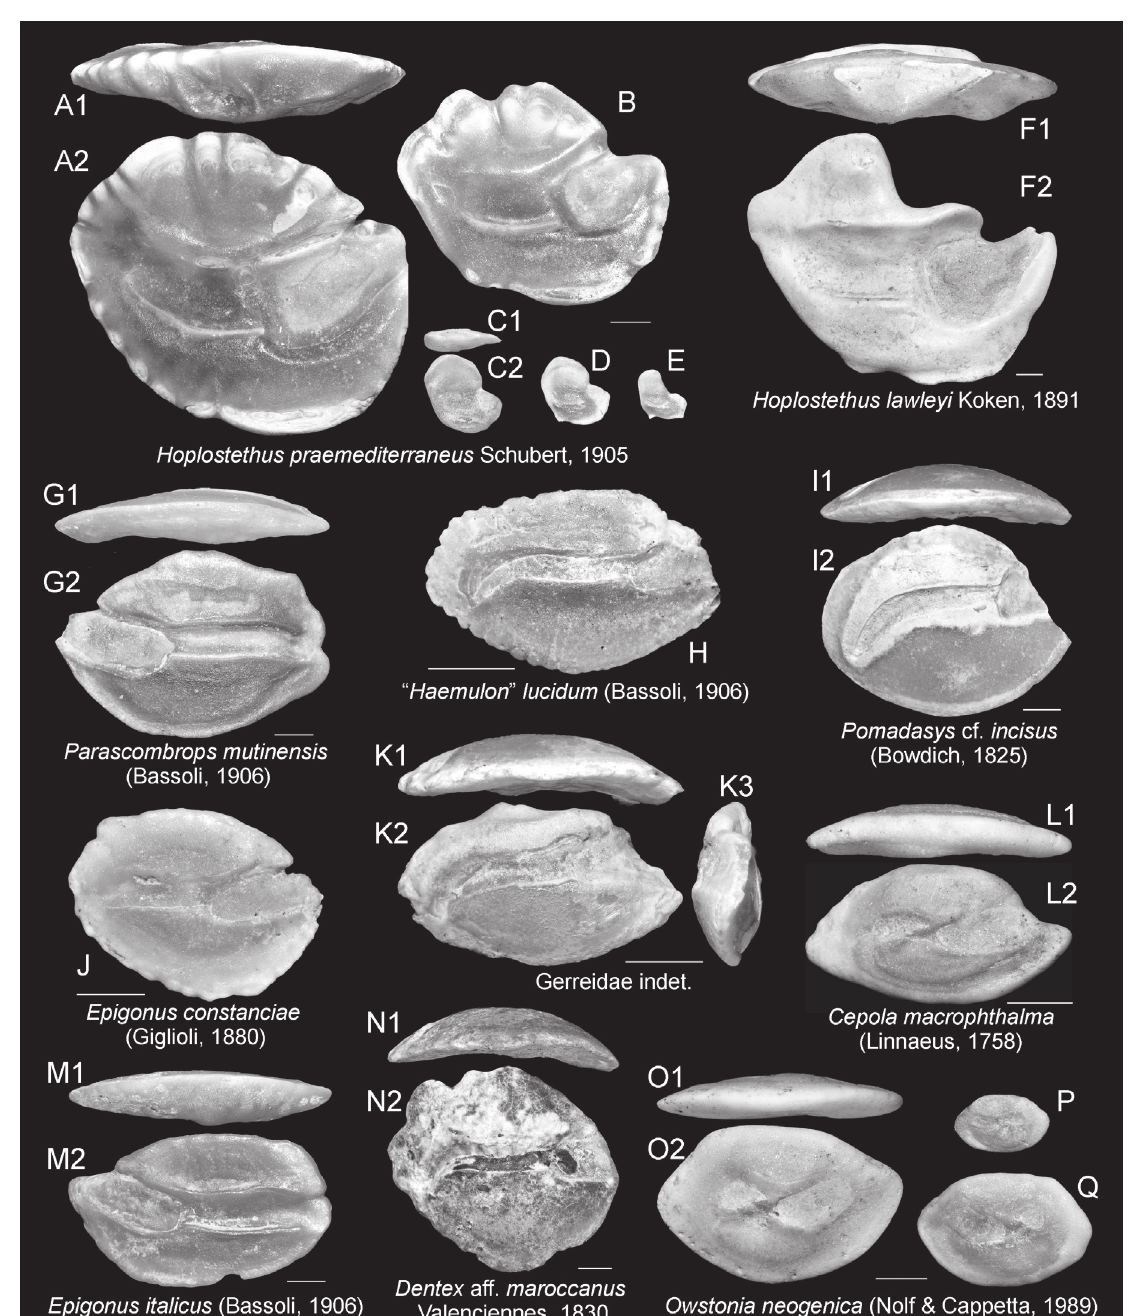
Fig. 10. Tortonian fish otoliths from northern Italy. A–E . Hoplostethus praemediterraneus Schubert, 1905; A–B . Montegibbio, C–E . Sant’Agata Fossili (IRSNB P 9804–P 9808). F . Hoplostethus lawleyi Koken, 1891, Sant’Agata Fossili (IRSNB P 9809). G . Parascombrops mutinensis (Bassoli, 1906), Torrente Stirone (IRSNB P 9810). H . “ Haemulon ” lucidum (Bassoli, 1906), Montegibbio (IRSNB P 9811). I . Pomadasys cf. incisus (Bowdich, 1825), Sant’Agata Fossili (IRSNB P 9812). J . Epigonus constanciae (Giglioli, 1880), Torrente Stirone (IRSNB P 9813). K . Gerreidae indet., Montegibbio (IRSNB P 9814). L . Cepola macrophthalma (Linnaeus, 1758), Torrente Stirone (IRSNB P 9815). M .